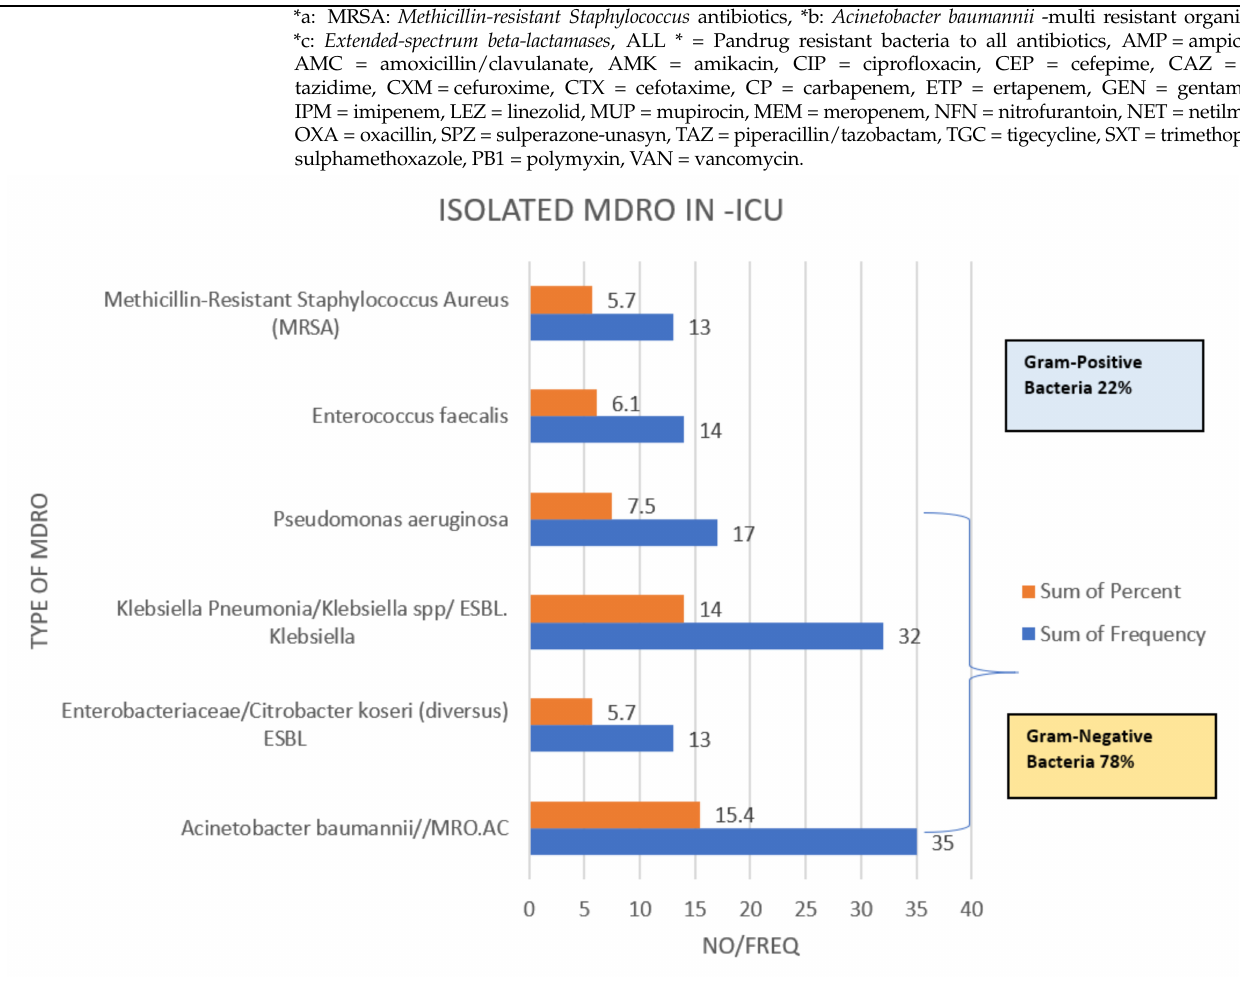
Figure 1. Most common isolated Multi drug resistant organisms (MDRO) in Sepsis ICU